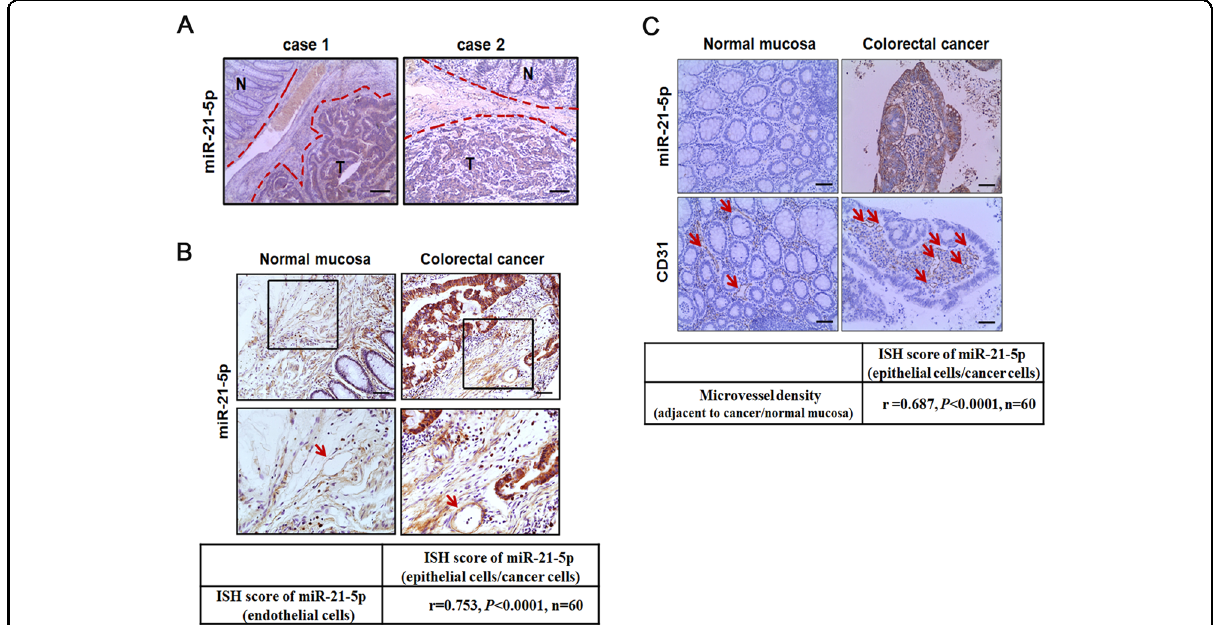
Fig. 1 Expression and localization of miR-21-5p in CRC. A Expression of miR-21-5p in primary CRC tissues (T) and matched adjacent normal mucosa (N) by ISH ( n = 60). Scale bars represent 100 µm. B Expression of miR-21-5p in vessels (indicated by arrows) adjacent to primary CRC tissues and matched adjacent normal mucosa by ISH. Correlation analysis of miR-21-5p expression in colorectal epithelial cells/cancer cells and their adjacent endothelial cells. MiR-21-5p levels were scored as described in “ Methods ” . Spearman ’ s correlation coef fi cient ( r ) and P -value are shown ( n = 60). Scale bars in top panels represent 50 µm. C Correlation analysis of miR-21-5p expression in colorectal epithelial cells/cancer cells and their adjacent microvessel density (labeled by CD31 and indicated by arrows). Microvessel density was scored as described in Methods. Spearman ’ s correlation coef fi cient ( r ) and P -value are shown ( n = 60). Scale bars represent 50